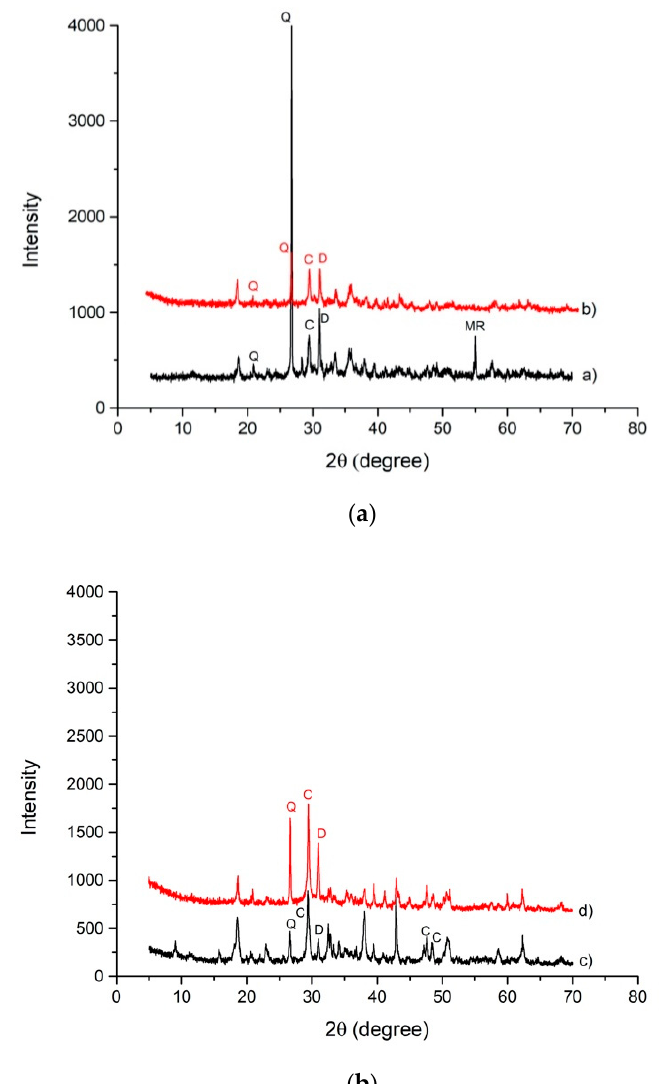
Figure 7. ( a ) XRD patterns of Slag A a) and A50NW AAM b) (C = calcite, Q = quartz, D = dolomite, MR = merwinite). ( b ) XRD patterns of Slag R c) and R50NW AAM d) (C = calcite, Q = quartz, D = dolomite).